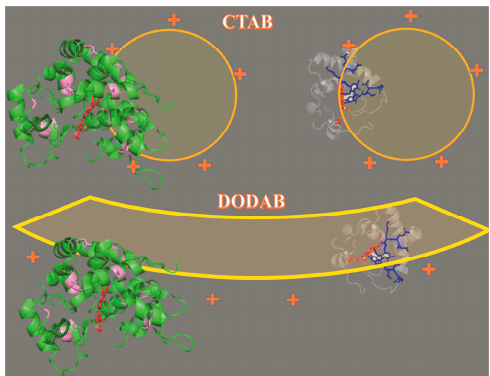
Figure 10. Cartoon of putative interactions of HRP and MP-11 with CTAB micelles and DODAB vesicles. HRP and cytochrome c structures were generated in PyMol 4.3software, using the respective data for 1H58 and 1HRC that are available in Protein Data Bank. The MP-11 structure was highlighted in blue in the structure of cytochrome c (transparent gray). The structure of HRP (green) has the acidic amino acid residues that are responsible for the affinity to the positively charged interfaces highlighted in light cyan.